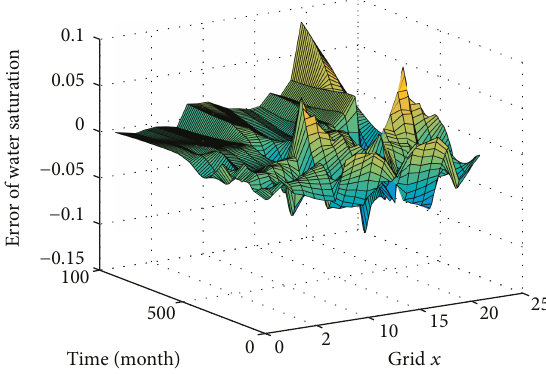
Figure 9: Modeling error of water saturation.